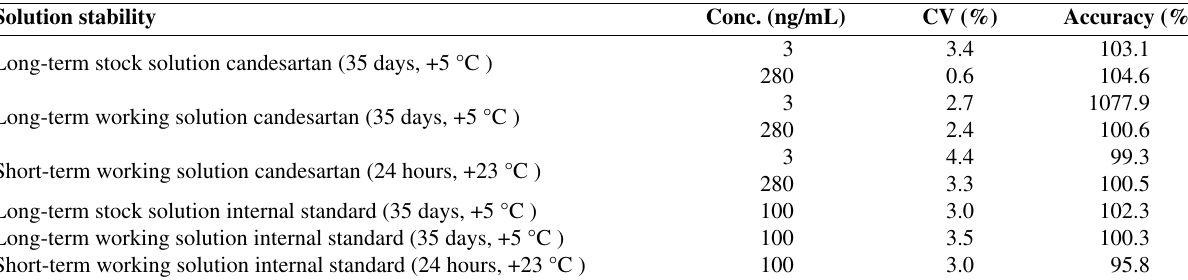
Table 4: Stability of candesartan and internal standard in solutions. Solution stability